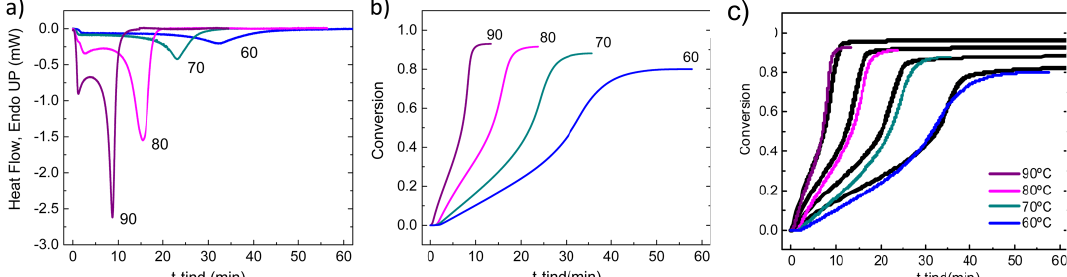
Figure 7. ( a ) Heat flow measured in the nanoconfined polymerization of MMA in AAO 60 at different temperatures under isothermal conditions. ( b ) Evolution of conversion with time. ( c ) Kinetic plot of MMA polymerization conducted in AAO templates with nanopore of 60 nm diameter at 60, 70, 80 and 90 °C. The bold lines indicate the fit of the kinetics to the mathematical model described herein [126]. Copyright 2017. Reproduced with permission from the publisher: ACS.